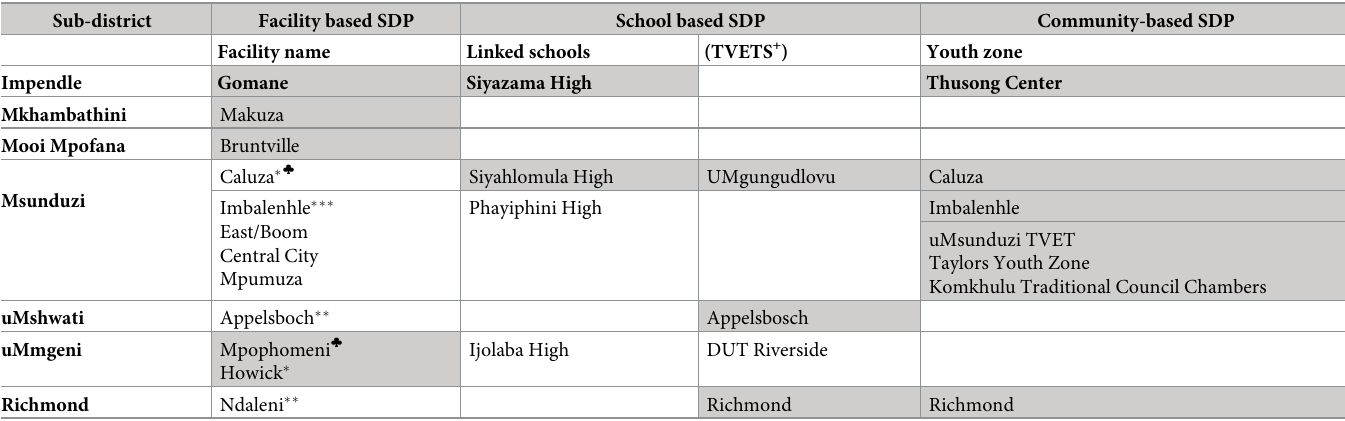
Table 2. Service delivery points selected for inclusion in the SHeS’Cap-PrEP study in uMgungundlovu district, KZN, 2021. Sub-district